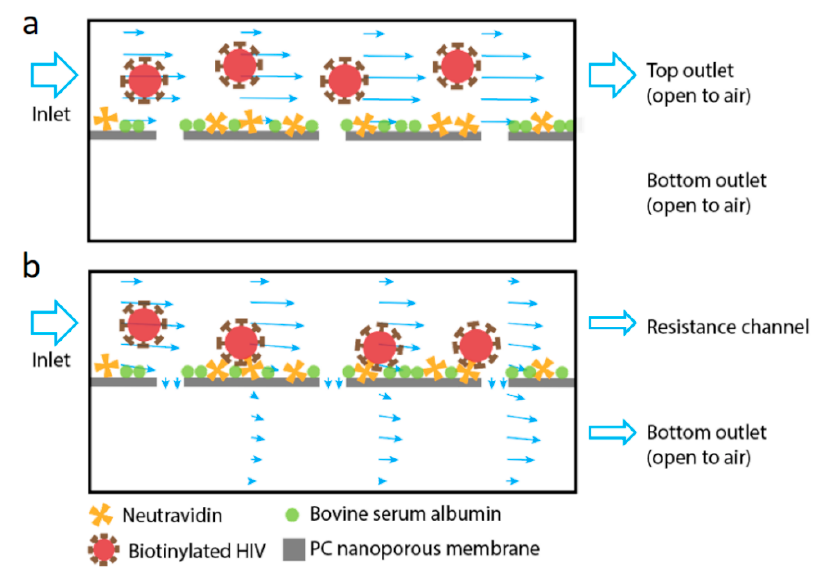
Figure 1. Schematics of the working principle of the device used in this work. The device is comprised of two flat channels separated vertically by a polycarbonate (PC) nanoporous membrane (pore size of 50 nm). The membrane is functionalized with NeutrAvidin to capture the biotinylated virus, with nonspecific binding blocked by bovine serum albumin. ( a ) When there is no cross-membrane flow, the virus primarily flows through the top channel. ( b ) When filtration is promoted using a resistance channel connected to the top channel, fluid enters the device through the top channel inlet and exits from both top (retentate) and bottom (permeate) outlets of the filtration device. The virus is pushed onto the membrane and captured by affinity binding. The arrows in the channels indicate local fluid velocity magnitude and direction.